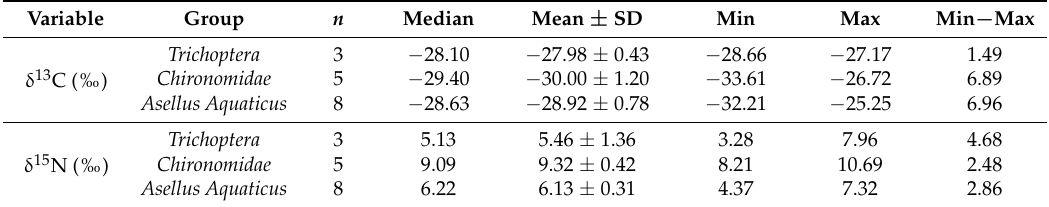
Table 3. Descriptive statistics for the stable isotope ratios δ 13 C and δ 15 N of the pooled benthic invertebrate